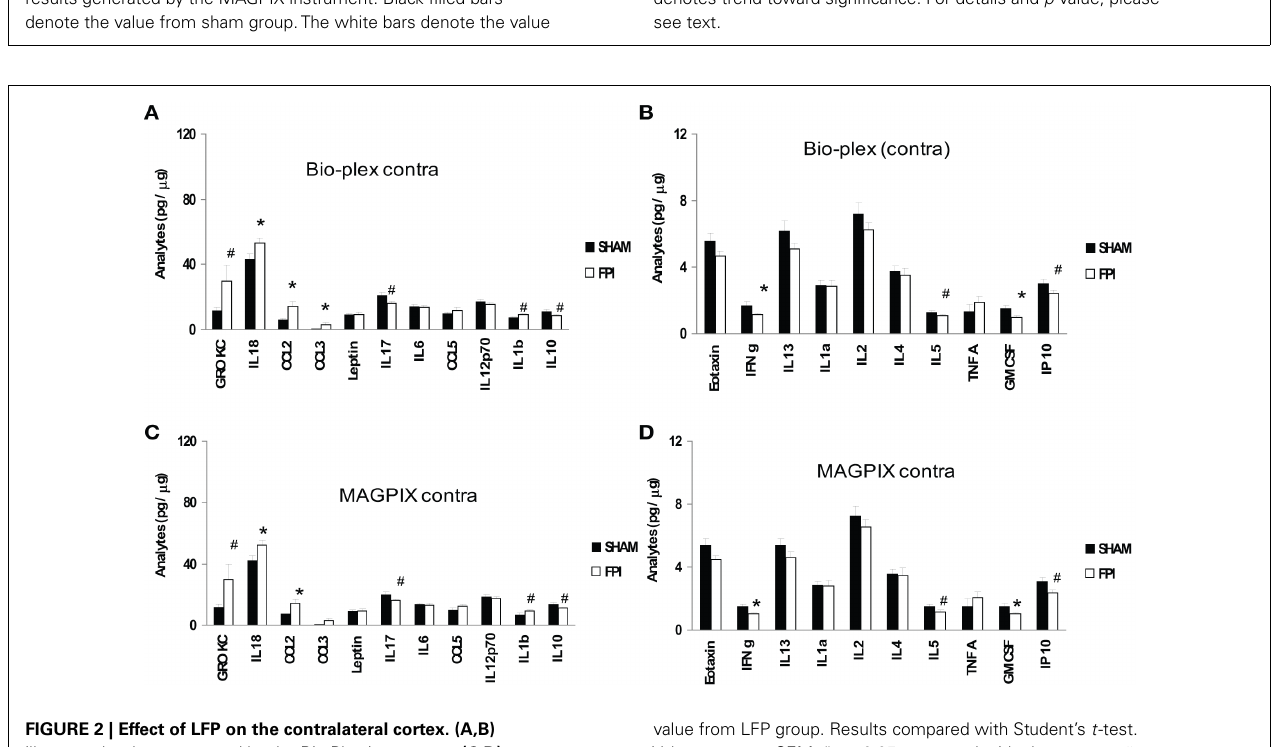
FIGURE 2 | Effect of LFP on the contralateral cortex. (A,B) illustrate the data generated by the Bio-Plex instrument. (C,D) illustrate the results generated by MAGPIX instrument. Black filled bars denote the value from sham group.The white bars denote the